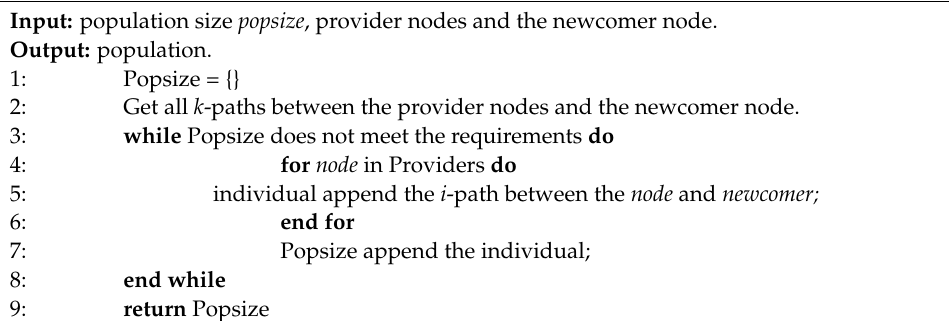
Algorithm 2 Initial